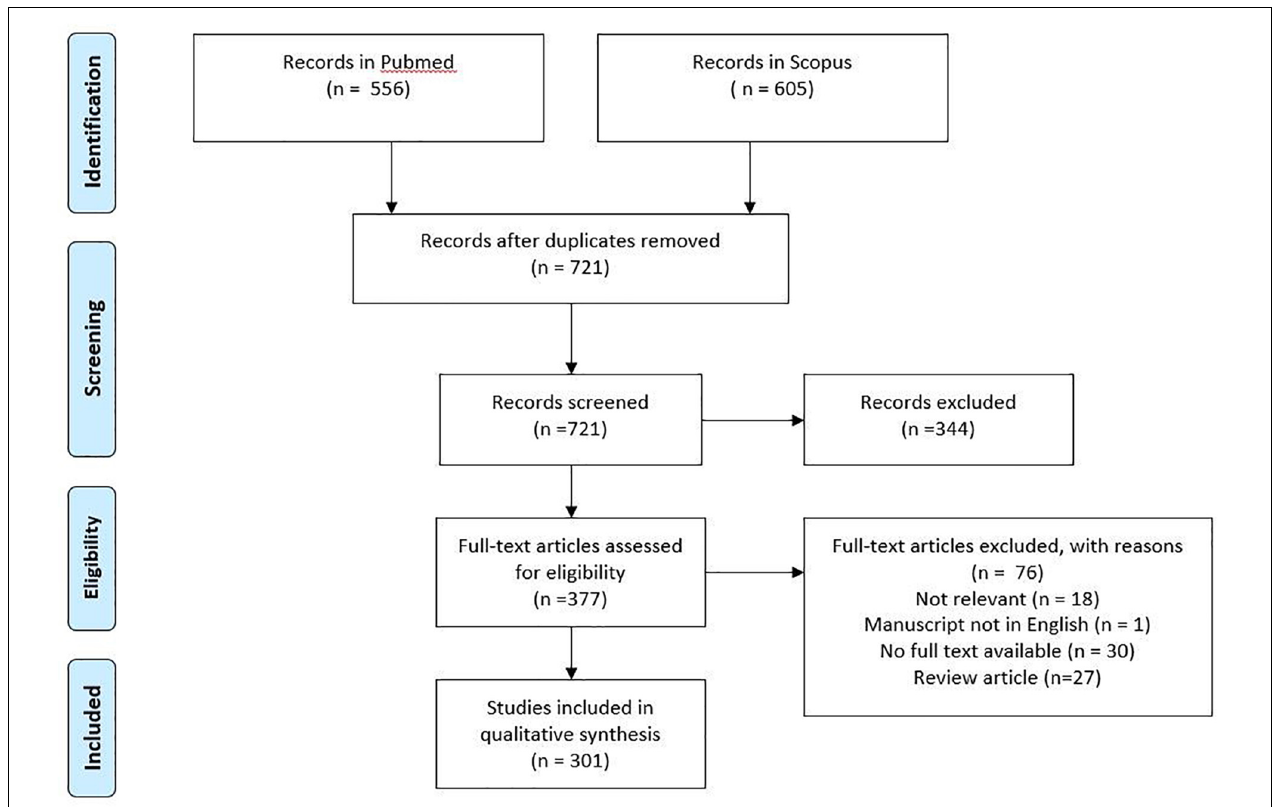
FIGURE 3 | PRISMA flowchart of the study selection